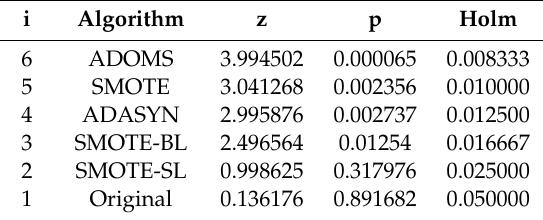
Table 22. Results of the Holm test comparing the performance of the Extended Gamma classifier after oversampling algorithms. The test rejects the hypothesis having an unadjusted p -value ≤ 0.025.